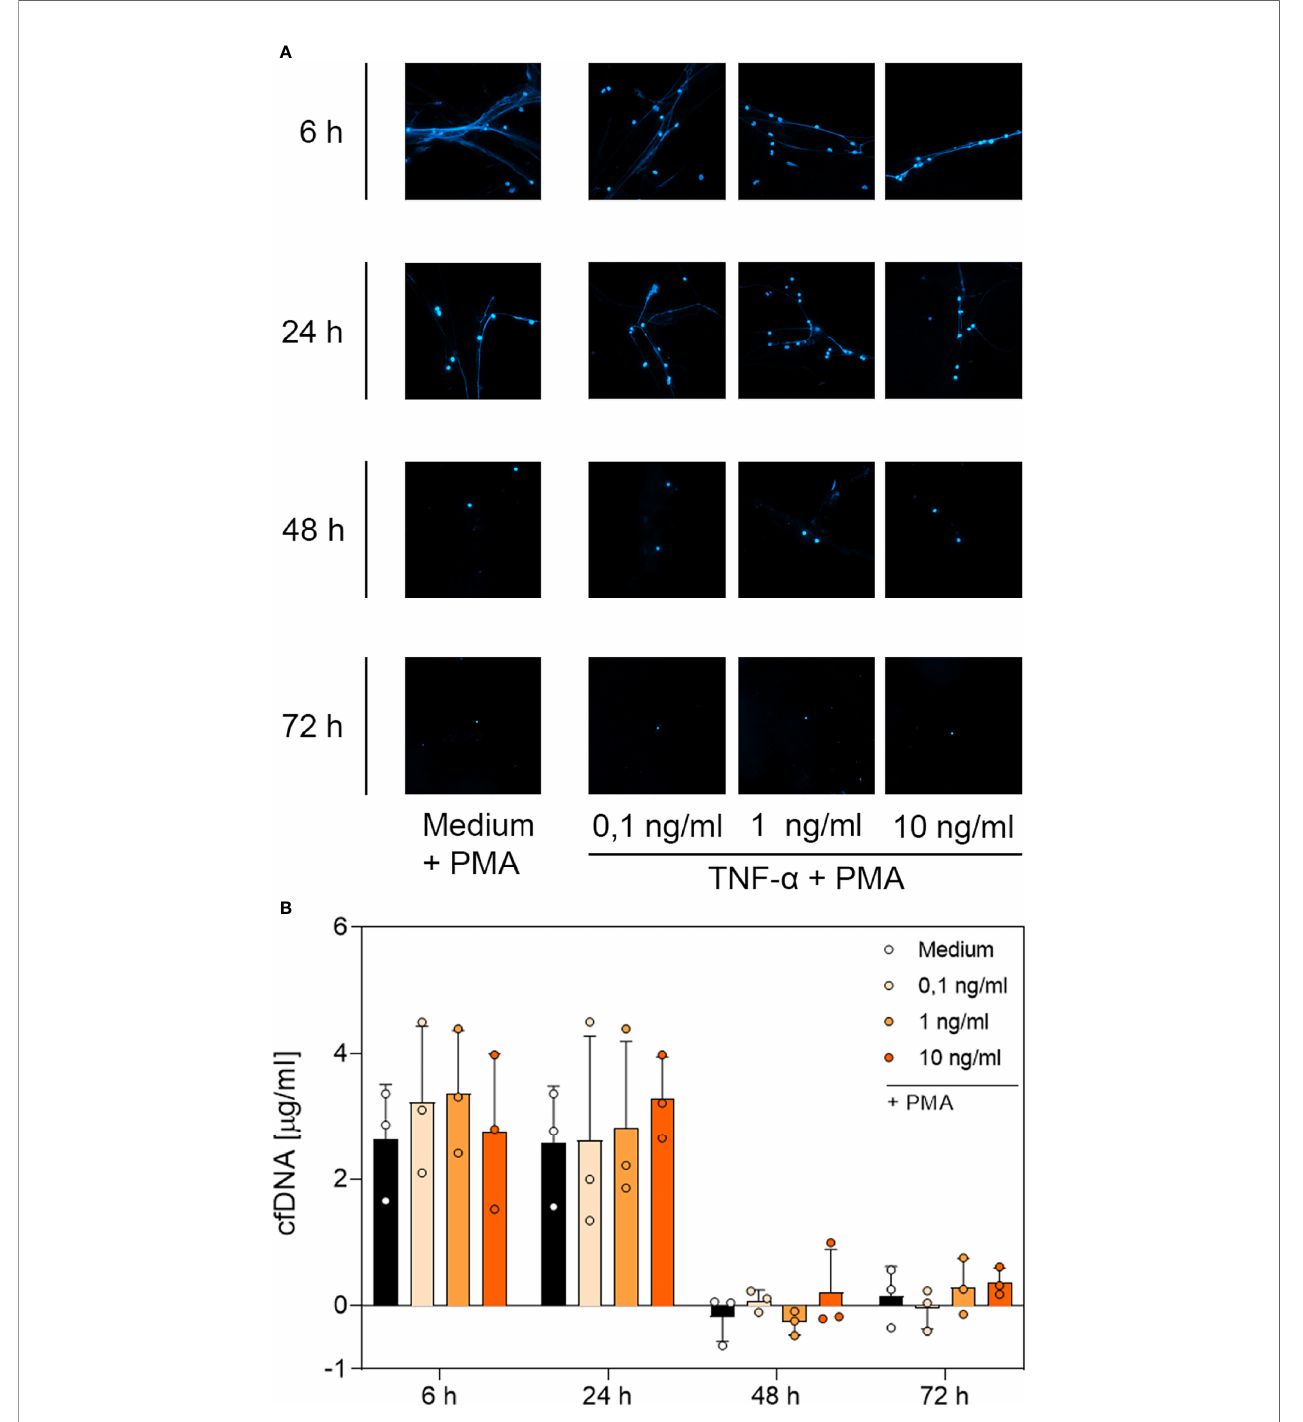
FIGURE 6 | Immuno fl uorescence imaging of NETs and quantitative analysis of PMA-induced cfDNA after incubation with TNF- a . (A) Immuno fl uorescence imaging shows extracellular DNA of neutrophils cultured with 0.1 ng/mL, 1 ng/mL, 10 ng/mL of TNF- a or of an untreated control (medium). Cells were stimulated with 20 nM PMA at the indicated time points. After fi xation, DNA was stained with 1 µg/mL DAPI (blue). PMA-induced NET formations can be detected after up to 24 h after treatment with TNF- a . Images represent areas with comparable cell density at 40× magni fi cation. (B) Quanti fi cation of PMA-induced cfDNA release by fl uorometric measurement of cfDNA after culturing neutrophil granulocytes with 0.1 ng/mL, 1 ng/mL or 10 ng/mL TNF- a compared to an untreated control (medium). Fluorometric measurement was conducted with samples stimulated with 20 nM PMA after 6 h, 24 h, 48 h and 72 h. TNF- a preserves cfDNA release for up to 24 h with no signi fi cant difference compared to the untreated group. Values represent means ± SD of n = 3. Differences between the untreated control group and one treated group each were calculated individually using student ’ s t-test. Levels of signi fi cance set at <0.05 were not